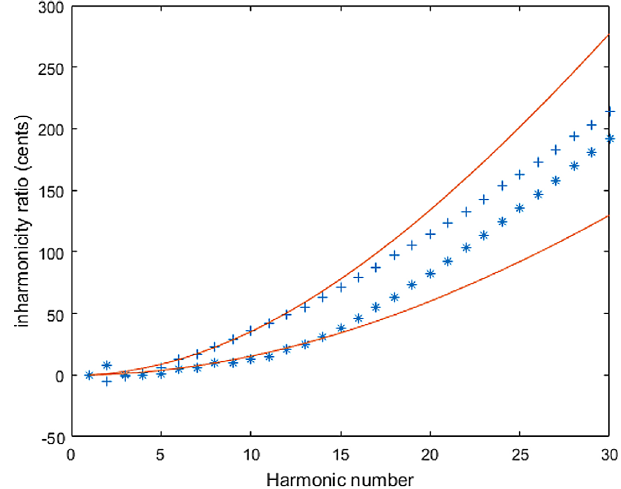
Figure 9. Inharmonicity ratio f n (cents) versus harmonic nf 1 number. +: C0 without mass; *: C0 with mass. Continuous ffiffiffiffiffiffiffiffiffiffi p ffiffiffiffiffiffiffi 1 þ Bn 2 curves: p with B = 4.2 (cid:3) 10 (cid:2) 4 and B = 1.8 (cid:3) 10 (cid:2) 4 1 þ B respectively.